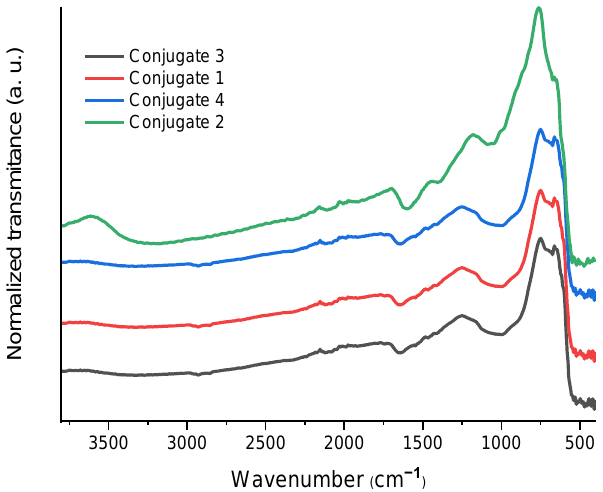
Figure 6. FTIR spectra of the final conjugates: Fe 3 O 4 @citrate@ > 10 kDa (conjugate 1), Fe 3 O 4 @citrate@